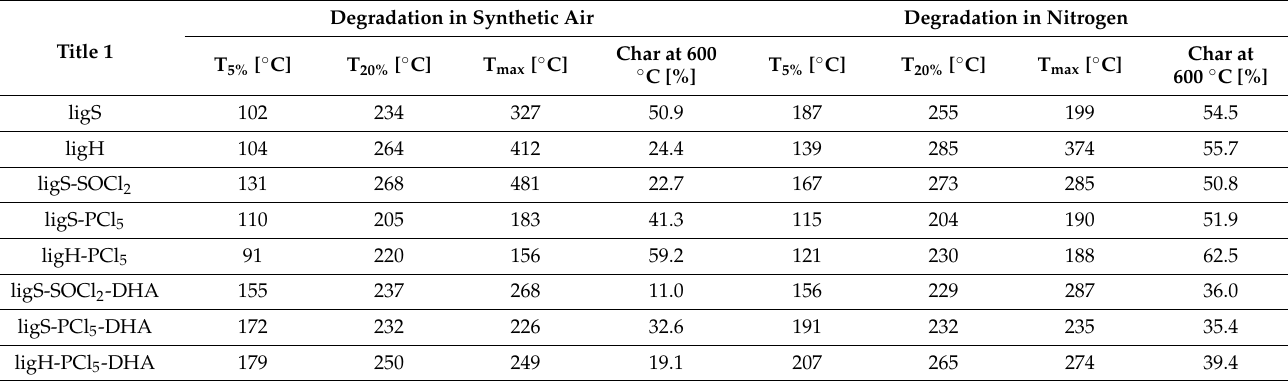
Table 2. Parameters of the thermal decomposition of the lignin-based